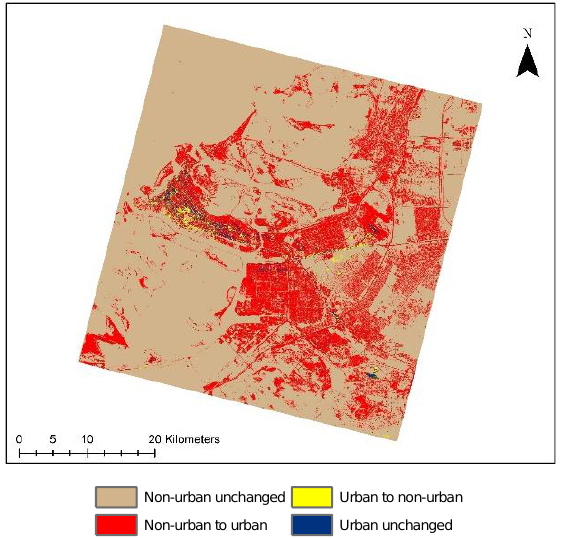
Figure 9: C hange map between Non-Urban and Urban classes in the study area (1990-2022). The conversion from non-urban to urban is very high, while urban to non-urban is very small and the areas of change are on the roadsides which signal the creation of green belts along the